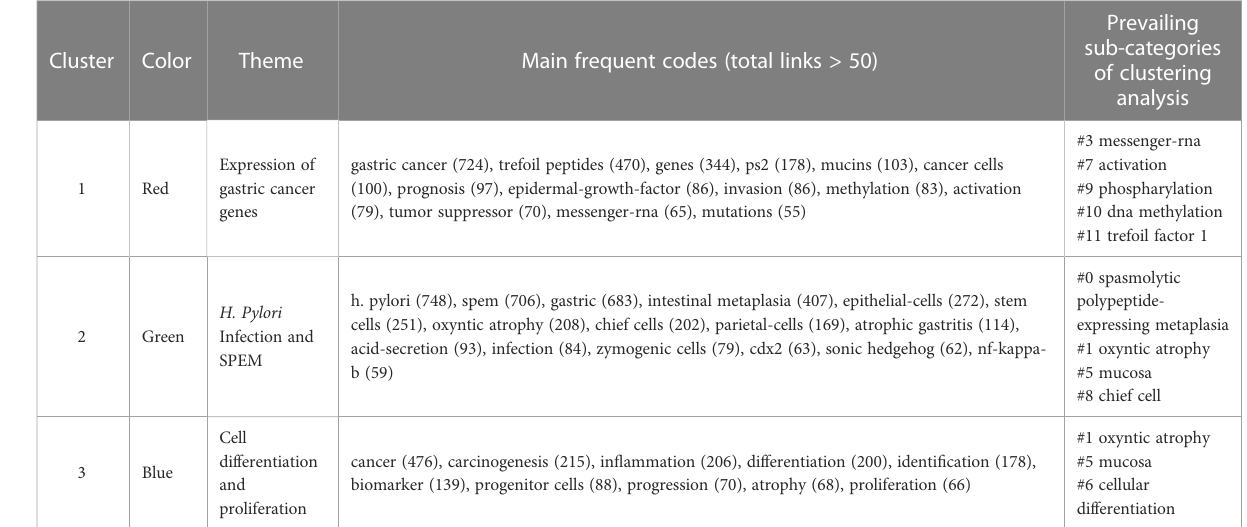
TABLE 7 Clusters of co-cited keywords specialized in SPEM-GC research.